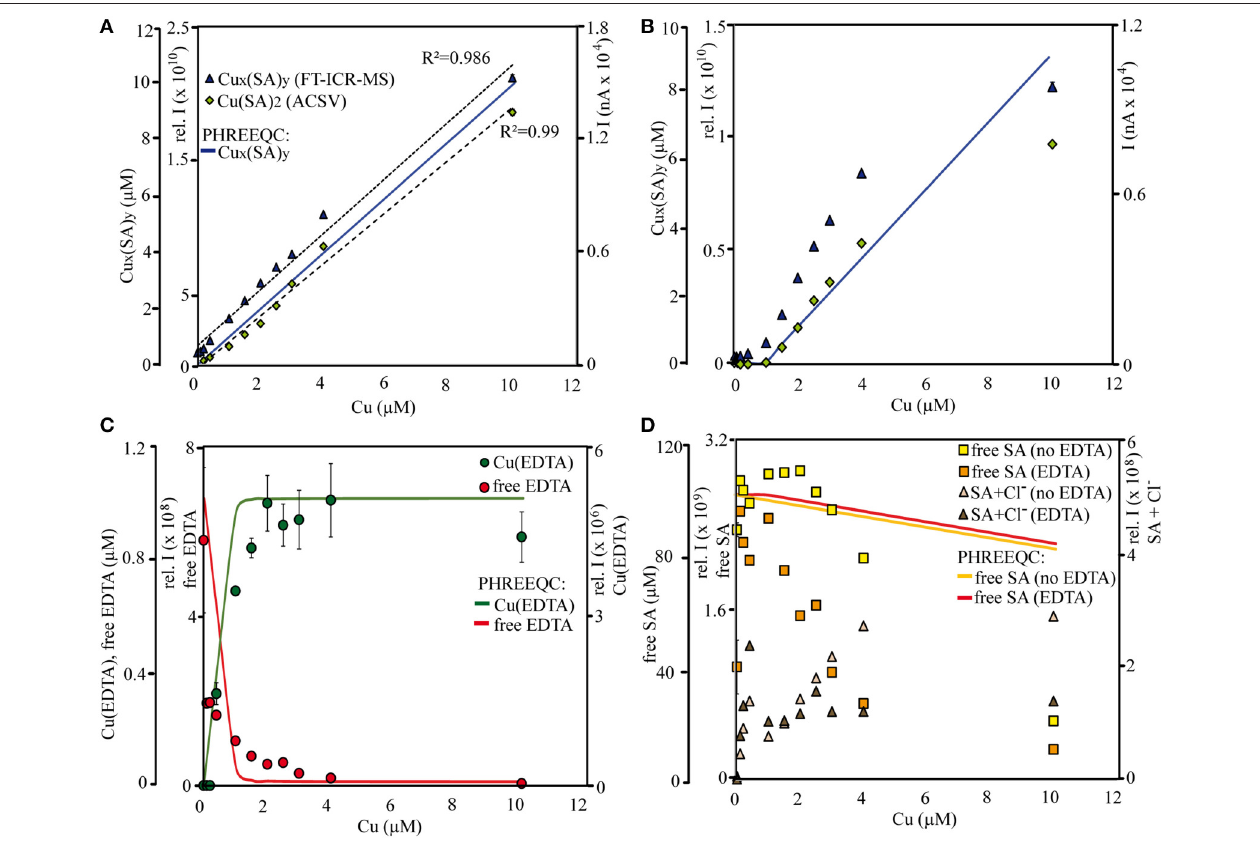
FIGURE 2 | Titration curves for Cu-SA species in treatments (A) without and (B) with 1 µ M EDTA, (C) for free and Cu-EDTA species in the EDTA treatments, and (D) for free SA and SA-Cl − species. Measurements were conducted (A–D) by FT-ICR-MS in negative ionization mode and (A,B) by (CLE-)ACSV. Calculations of µ M concentrations for (A,B) Cu-SA species, (C) free EDTA and Cu(EDTA), and (D) free SA species were conducted with PHREEQC. The results of the (CLE-)ACSV measurements were dilution-corrected to compare them with the FT-ICR-MS samples. All data points acquired by (CLE-)ACSV and FT-ICR-MS are averages from triplicate measurements of the same sample (error bars denote standard deviation). “Cu x (SA) y ,” “free SA x , ” “SA + Cl − ,” and “free EDTA” were calculated as the sum of intensities of all detected species fitting those categories (with and without Na +